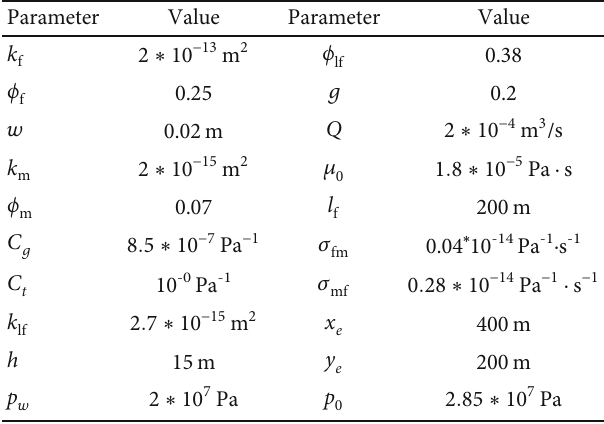
Figure 3: Microseismic data: (a) microseismic event distribution along the x and y directions, (b) matching C ð y Þ along the y direction. (c) matching C y Table 1: Parameters of the tight gas reservoirs [62] employed during model application.